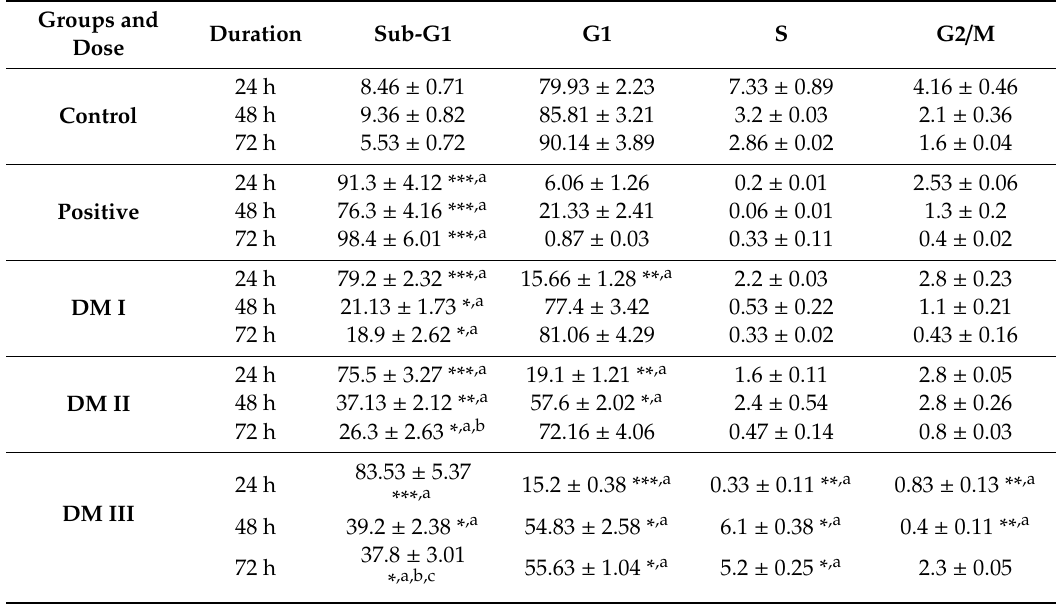
Table 5. Amino acid residues of Cyclin A2 involved in respective ligand interactions. Binding Compound Target